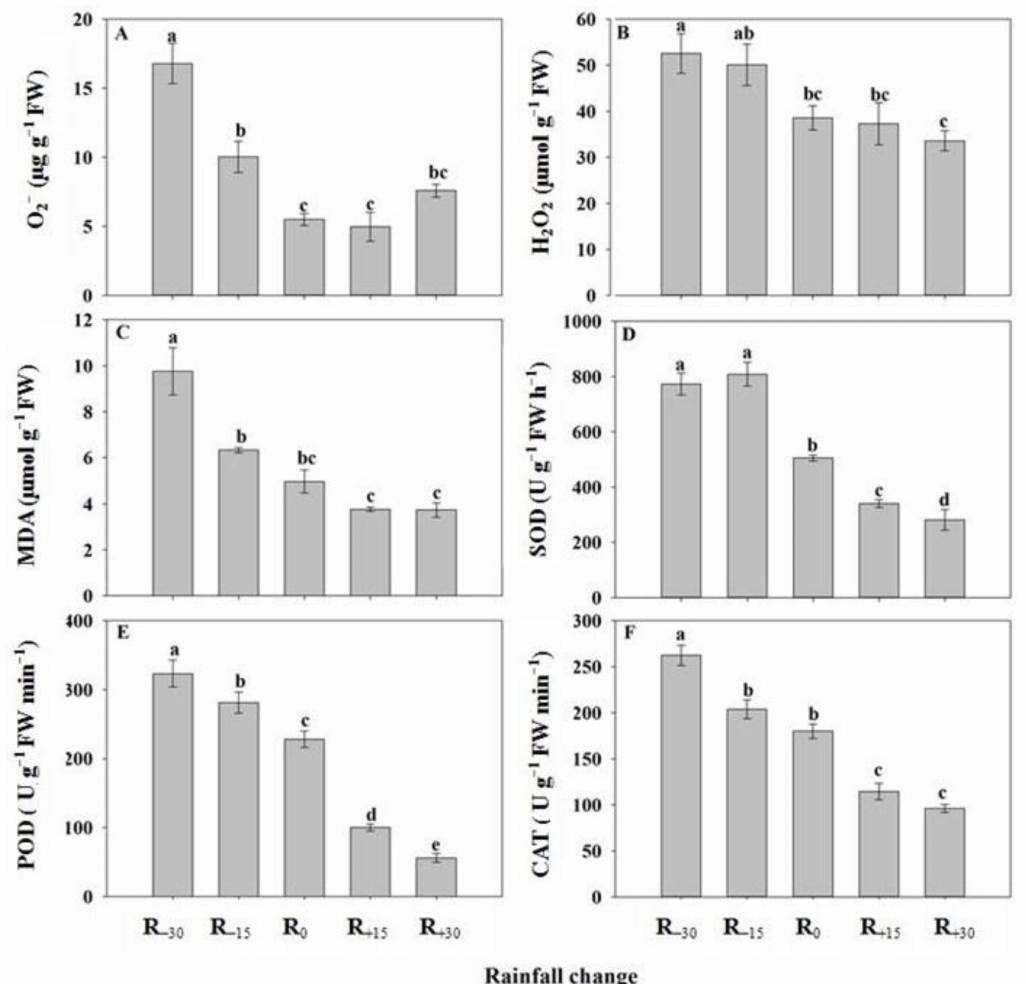
Figure 5. Changes in the antioxidant enzyme activities in Gymnocarpos przewalskii leaves under rainfall change. ( A ): O 2 − ; ( B ): H 2 O 2 ; ( C ): MDA; ( D ): SOD; ( E ): POD; ( F ): CAT; O 2 − , superoxide anion; H 2 O 2 , hydrogen peroxide; MDA, malondialdehyde; SOD, superoxide dismutase; POD, peroxidase; CAT, catalase; R 0 , mean monthly rainfall from May to August during the period from 1961 to 2018; R − 30 , R 0 decreased by 30%; R − 15 , R 0 decreased by 15%; R +15 , R 0 increased by 15%; R +30 , R 0 increased by 30%. Vertical bars represent the means ± SE (n = 3), and different lowercase letters above the bars indicate significant differences among the treatments ( p <